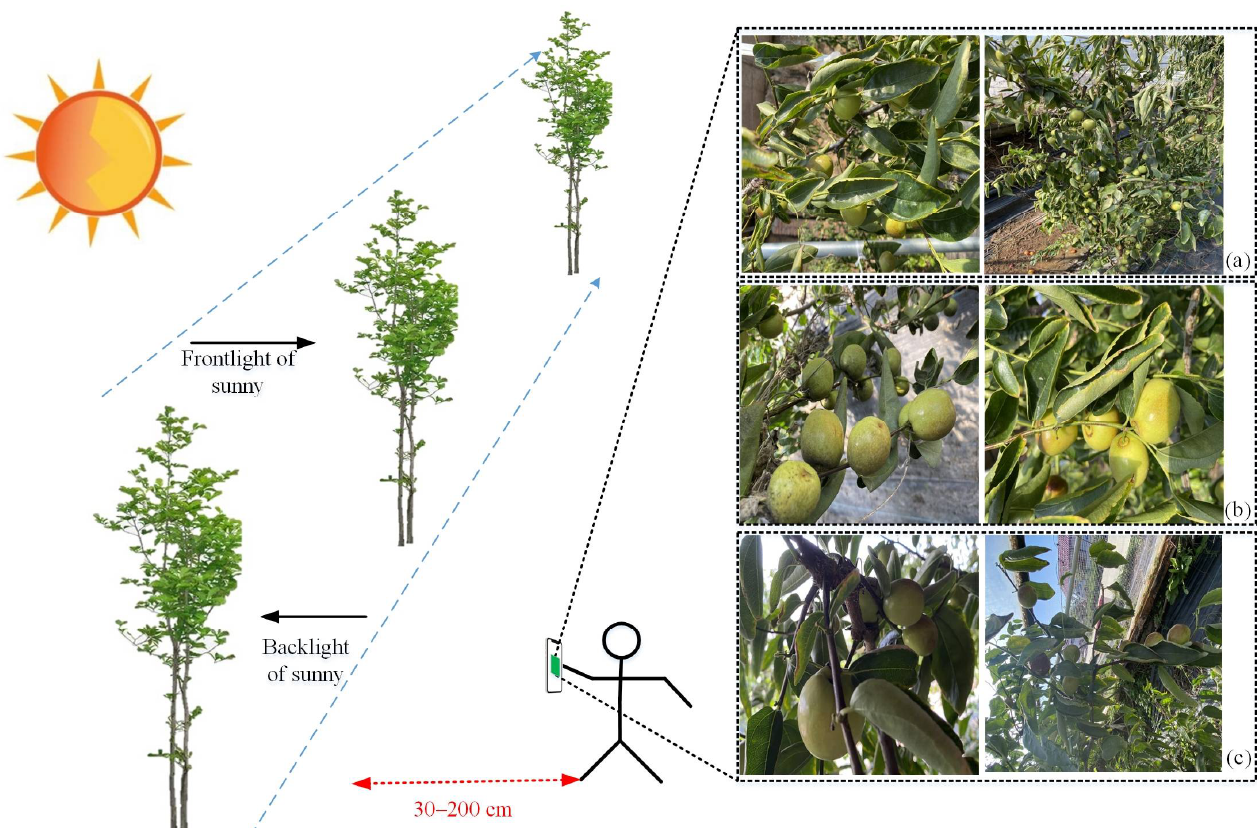
Figure 2. The acquisition process of the dataset. ( a ) Images under occlusion scene; ( b ) Images under front light; ( c ) Images under backlight scene.